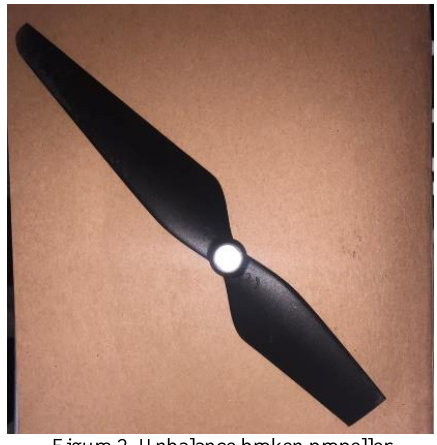
Figure 2. Unbalance broken propeller